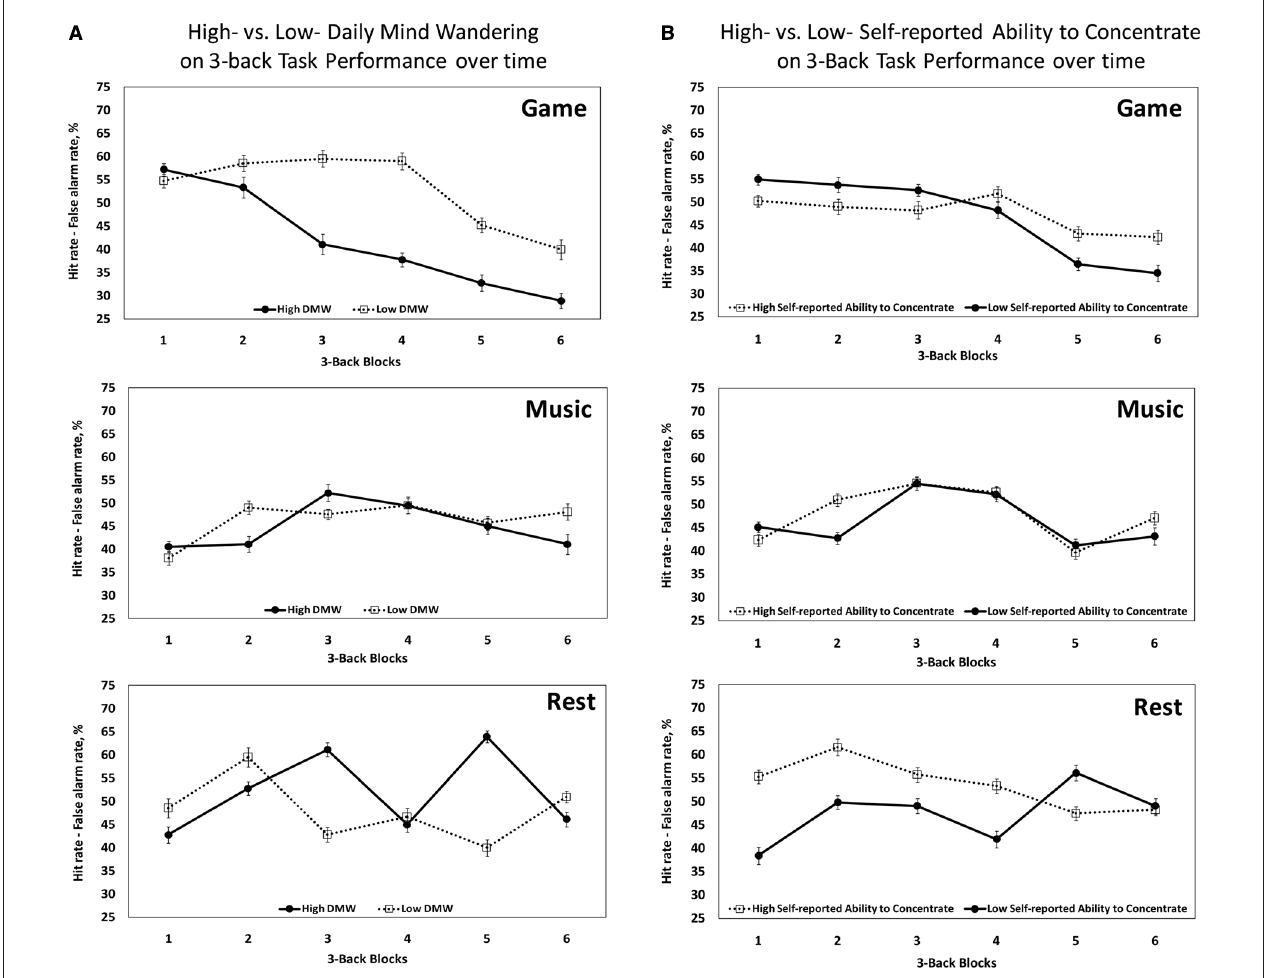
FIGURE 4 | The influence of daily mind wandering and self-reported ability to concentrate on 3-back task performance over six blocks, after gaming, listening to music or eyes-open resting. (A) The effect of high- ( N = 12) vs. low- ( N = 14) daily mind wandering (DMW) scores on 3-back task performance after game, music and rest, respectively. Subjects’ self-reported DMW score was ranked higher vs. lower than median ( N = 26/35: six subjects’ data in the median was removed). (B) The effect of high- ( N = 17) vs. low- self-reported ability to concentrate ( N = 17) scores on 3-back task performance after game, music and rest, respectively. Subjects’ self-reported ability to concentrate (i.e., the ability to concentrate on the task after the three break conditions), was ranked higher vs. lower than median ( N = 34/35: one subject’s data, in the median was